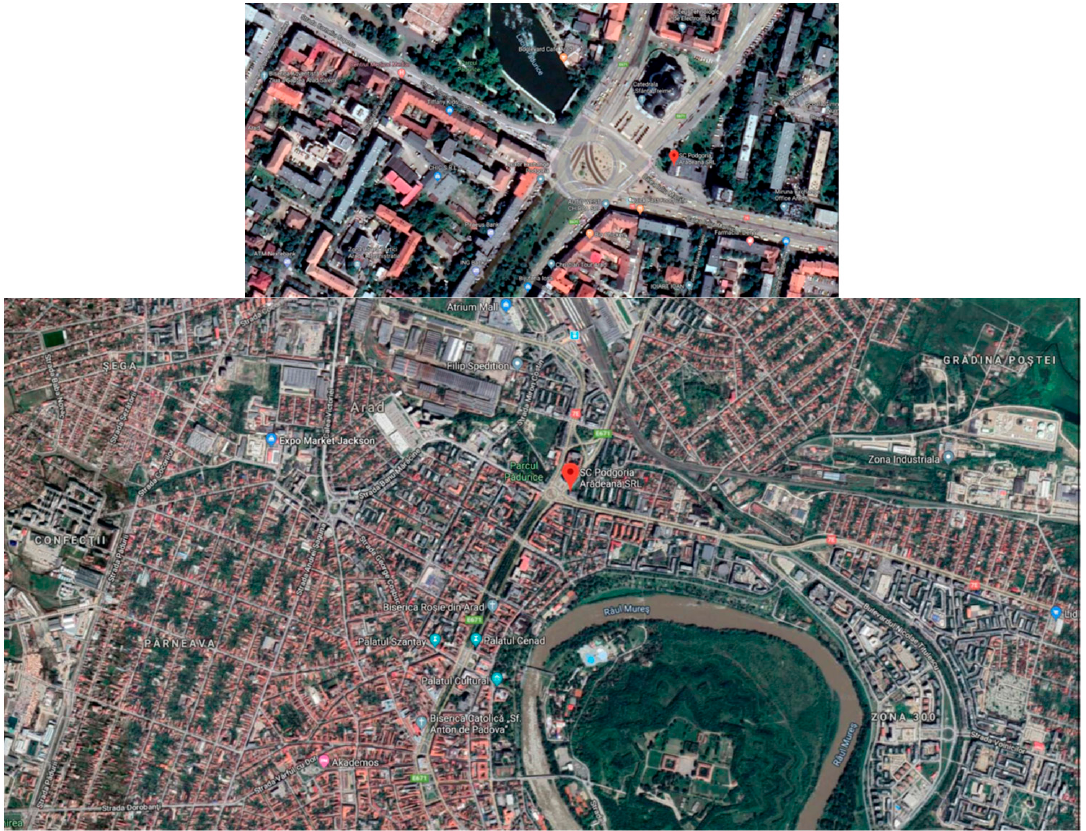
Figure 1. Satellite photos of Arad City Center. The position of the sampling site is marked with a red pin.